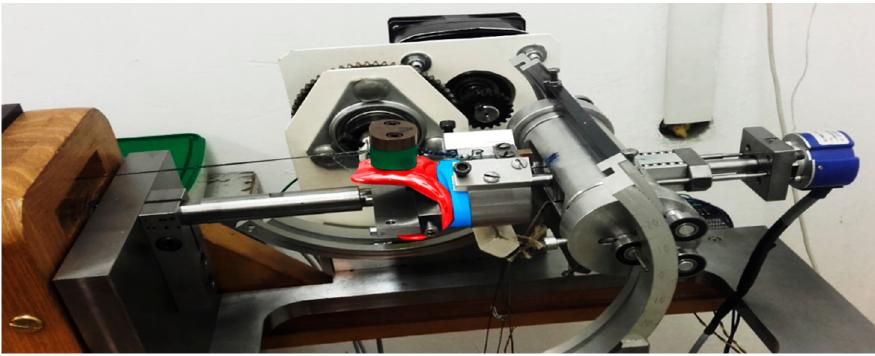
Figure 17. Machine for measurement of the knee prosthesis [12].